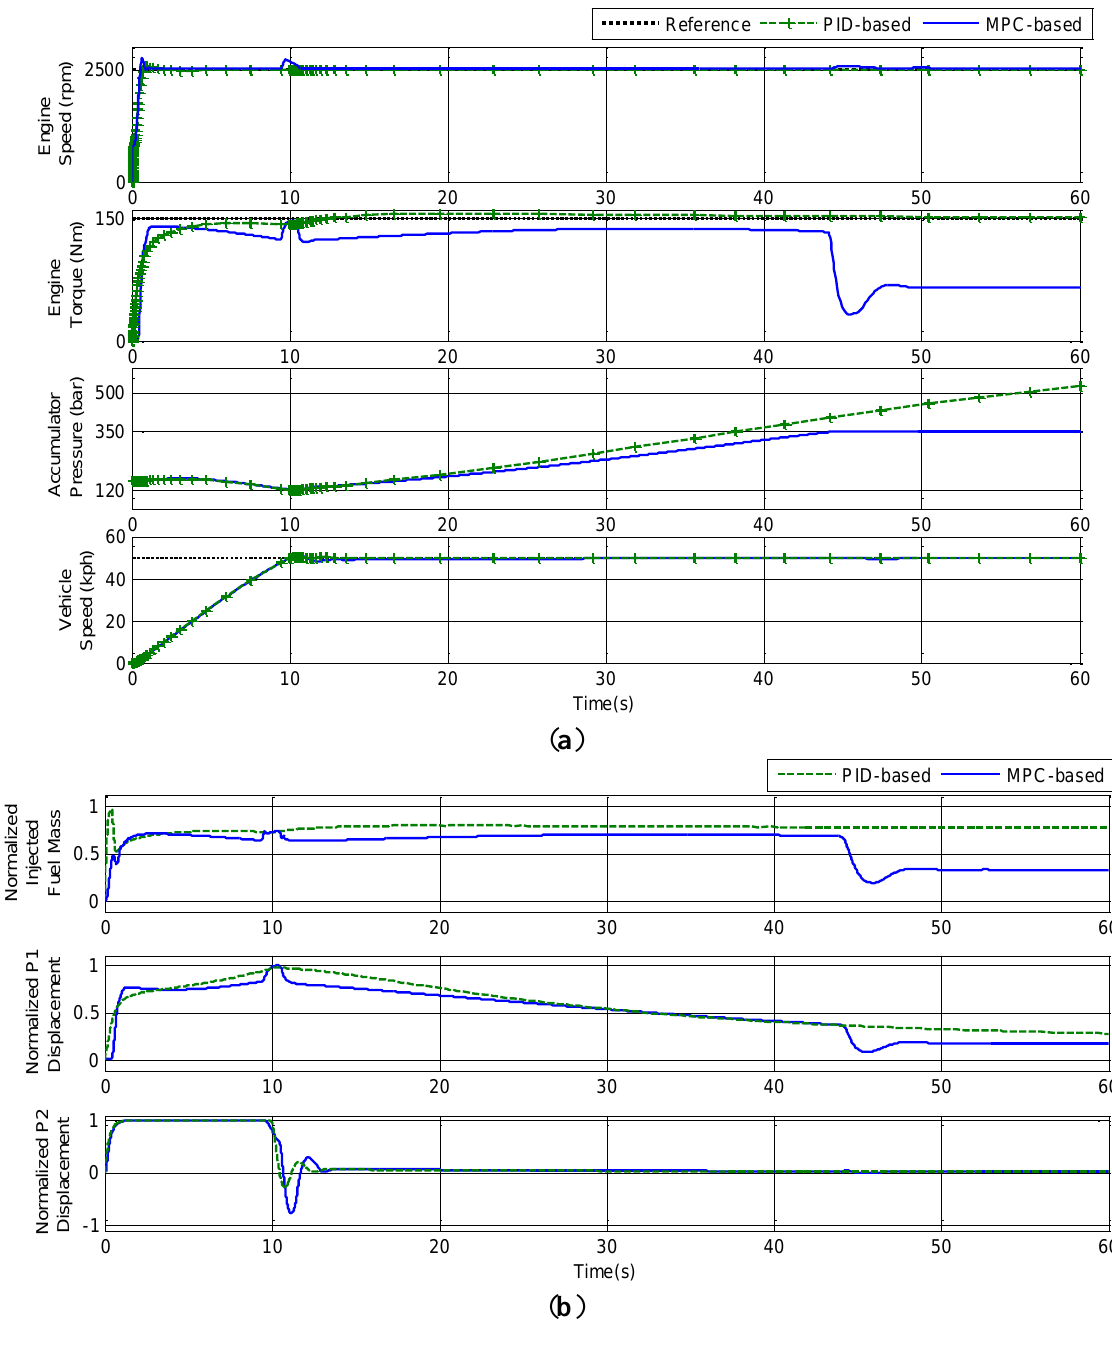
Figure 12. The behaviors of the SHHV with a low speed demand: ( a ) Outputs; and ( b )